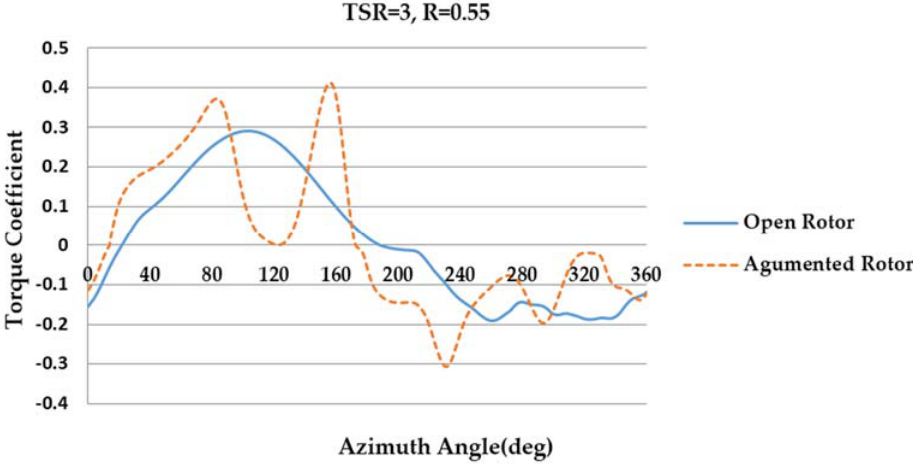
Figure 24. Torque coefficient versus azimuth angle for open and augmented rotor for TSR = 3, R shape ‐ ratio = 0.55.